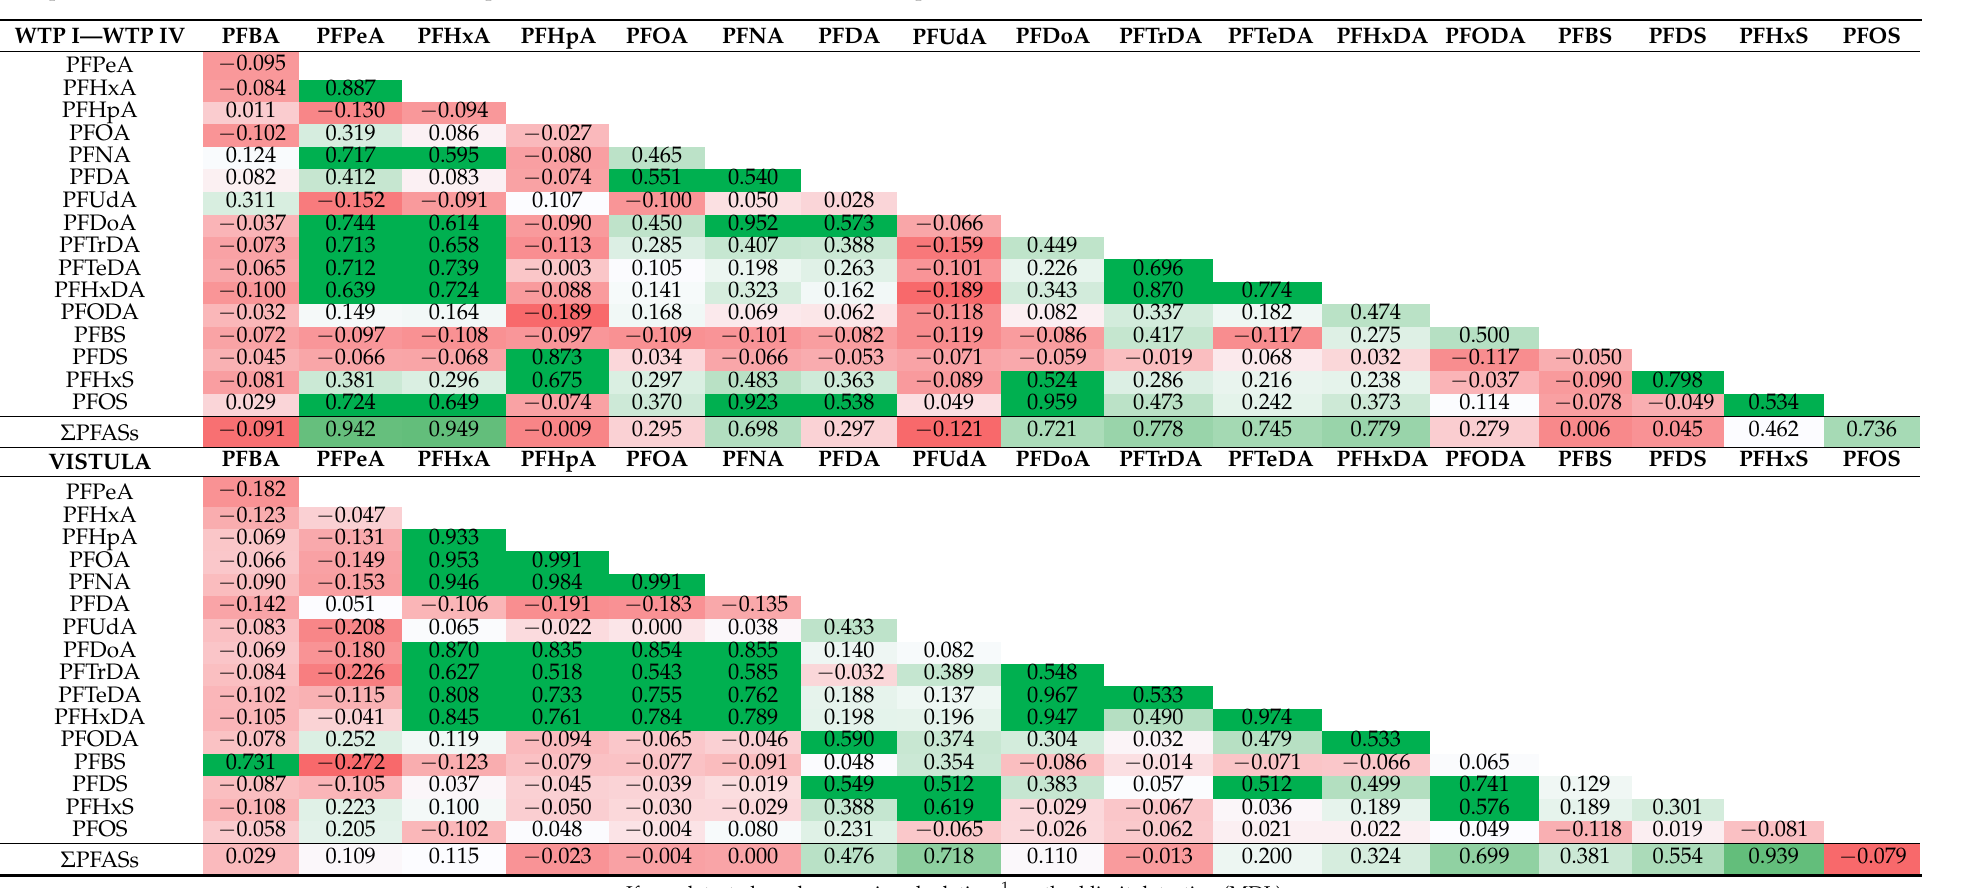
Table 1. Correlation coefficient of different PFASs in sediment from the Gulf of Gdansk (correlation is significant at p < 0.05, dark green color—strong correlation) (WTP I-IV-wastewater treatment plant, PFBA-perfluoro- n -butanoic acid, PFPeA-perfluoro- n -pentanoic acid, PFHxA-perfluoro- n -hexanoic acid, PFHpA-perfluoro- n -heptanoic acid, PFOA-perfluoro- n -octanoic acid, PFNA-perfluoro- n -nonanoic acid, PFDA-perfluoro- n -decanoic acid, PFUdA-perfluoro- n -undecanoic acid, PFDoA-perfluoro- n -dodecanoic acid, PFTrDA-perfluoro- n -tridecanoic